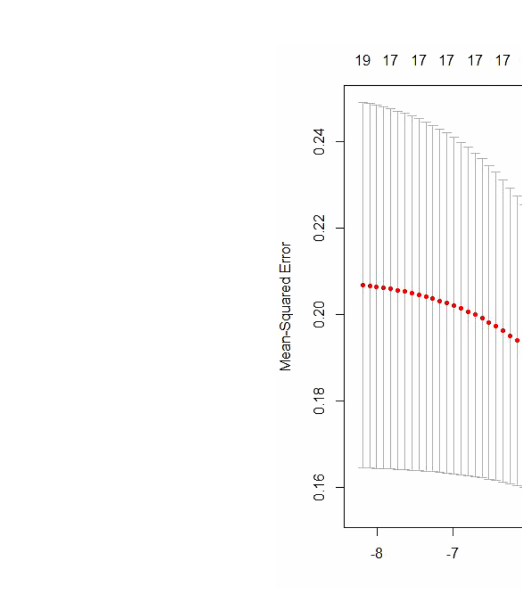
TABLE 2 The estimated coef fi cients in the stepwise logistic regression and logistic least absolute shrinkage and selection operator regression. Variable StepwiseLogistic LASSO